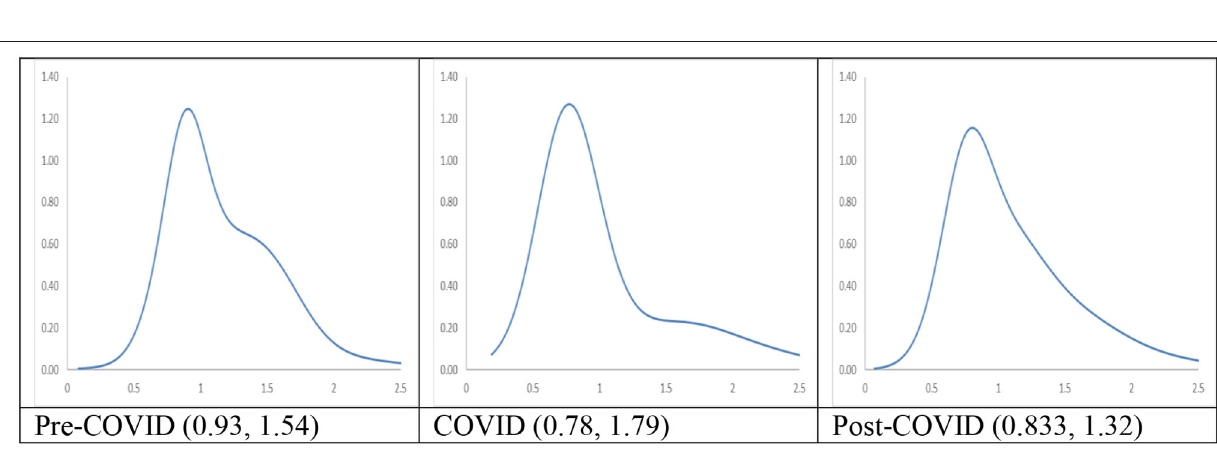
will converge to RDIPC value which is less than the Pre-COVID level and disparity will be intensified due to the